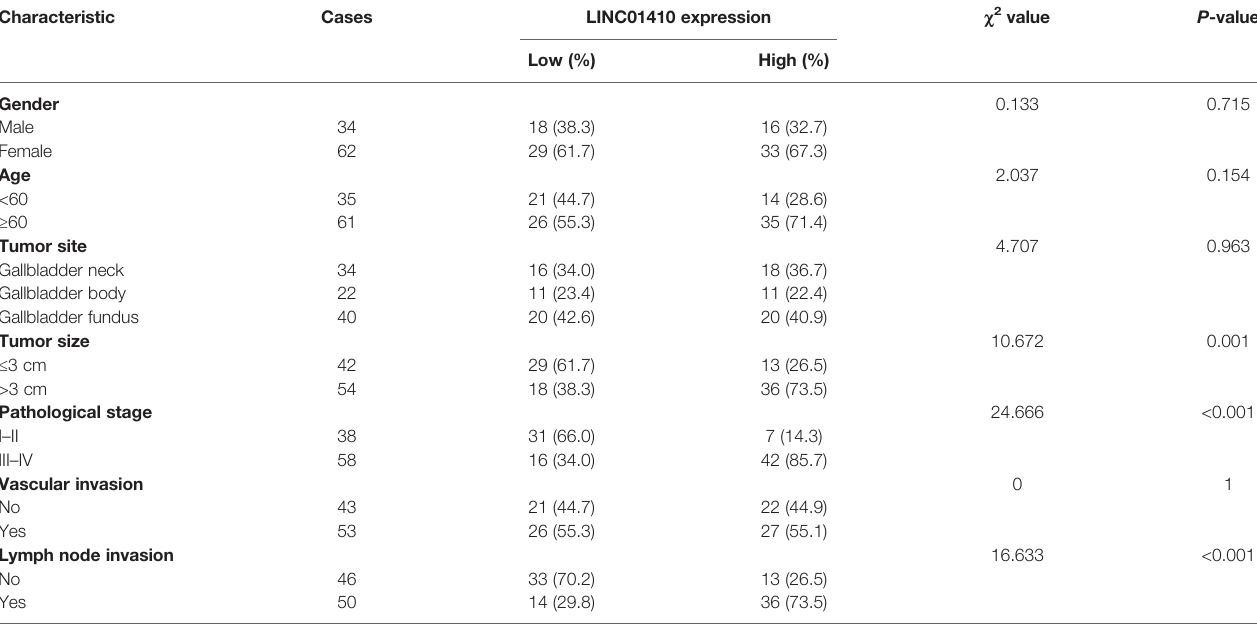
TABLE 1 | The relationship between LINC01410 expression and clinicopathologic characteristics of GBC patients in the present study. Characteristic Cases LINC01410 expression c 2 value P -value Low